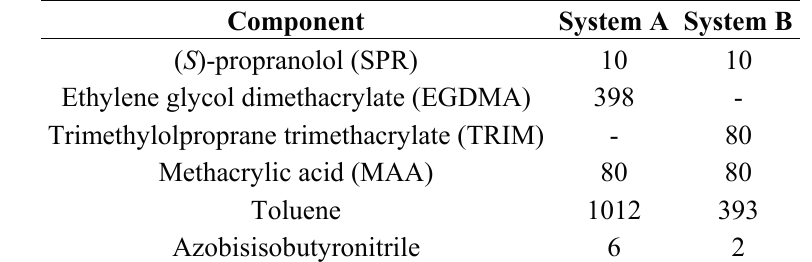
Table 1. Compositions of systems simulated (numbers of molecules present in mixture) a .